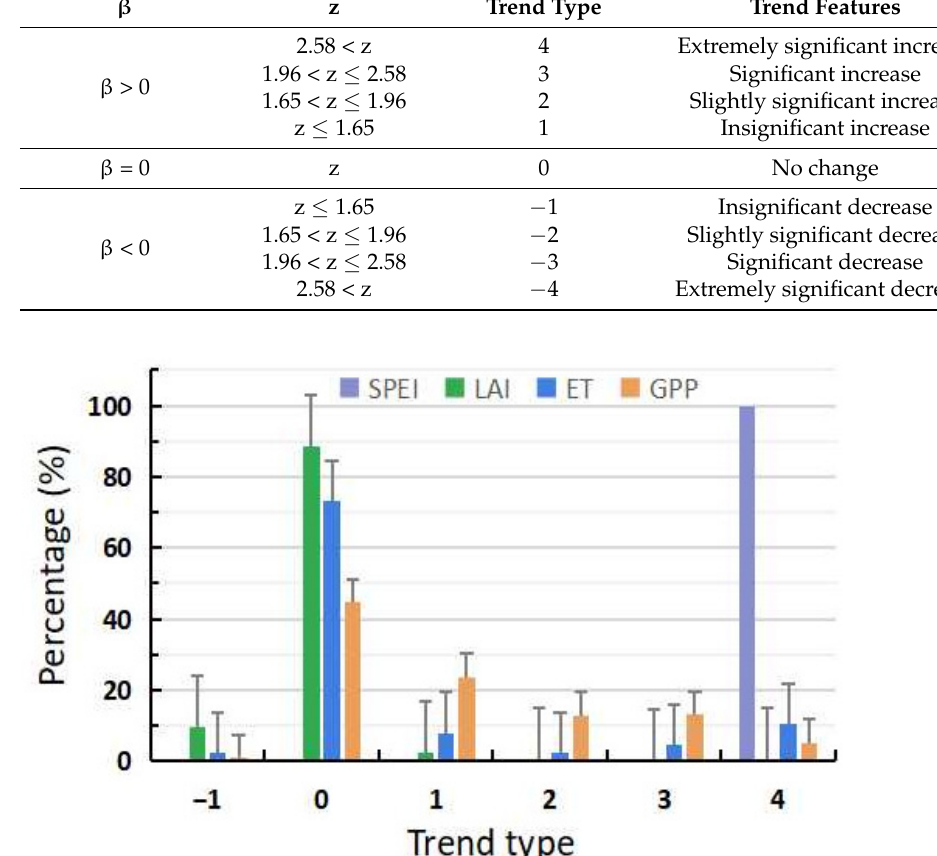
Figure 4. The pixel proportions of SPEI, LAI, ET, and GPP trend types from 2000 to 2020.